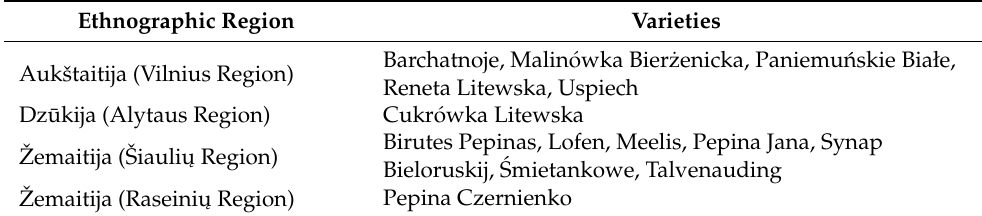
Table 2. Varieties of apple trees according to the ethnographic region of the collection. Ethnographic Region